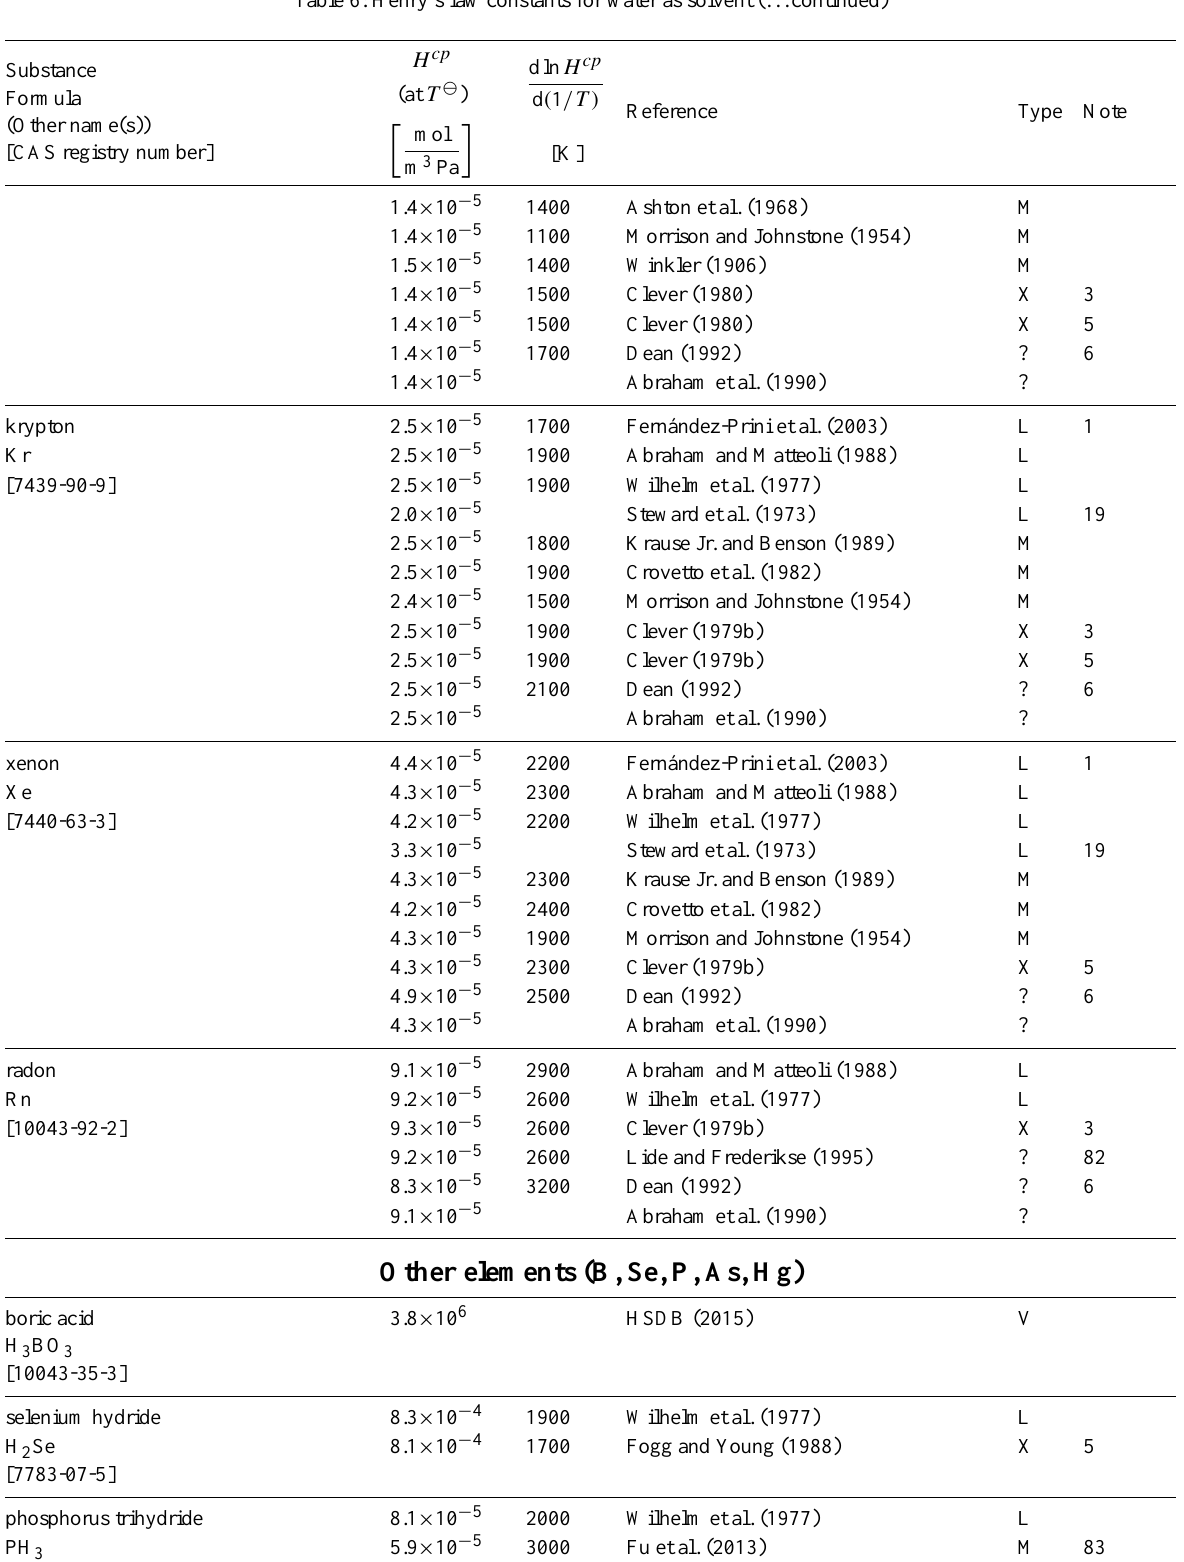
Table 6: Henry’s law constants for water as solvent